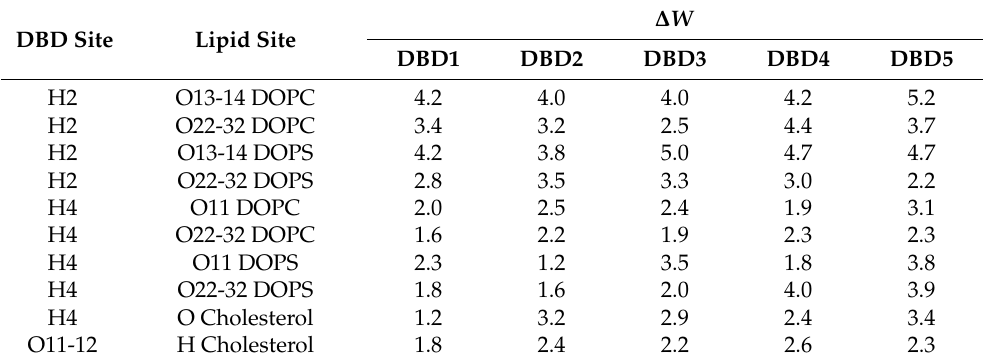
Table 2. Free-energy barriers ∆ W (in k B T ) from reversible work calculations for the binding of DBD to cholesterol, lipids and water. In order to quantify the height of all barriers, 1 k B T = 0.596 kcal/mol. Labels as indicated in Figure 1. Estimated errors of ± 0.1 in all